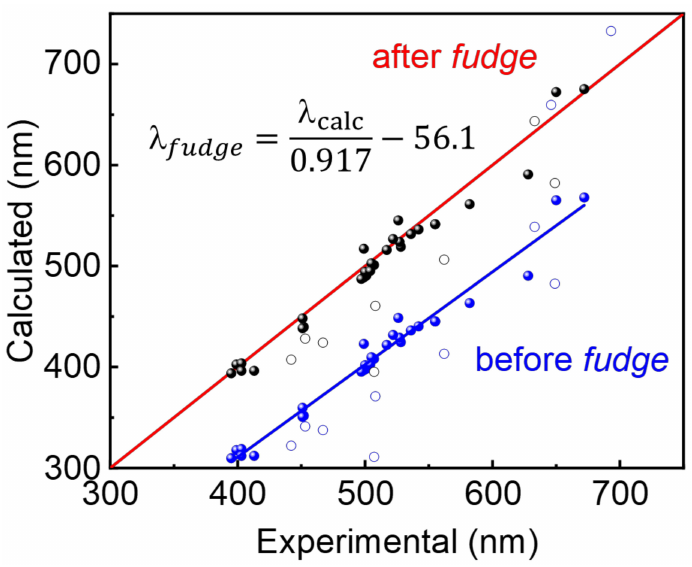
Figure 5. Linear correction obtained upon the use of the ω B97X-D with 6.311g (d,p) basis